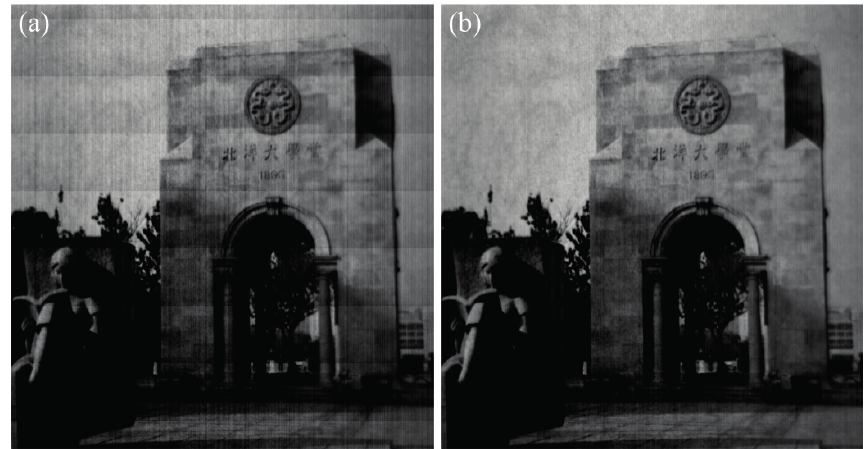
Figure 19. Comparison of visual effect of the Peiyang University Memorial. ( a ) Original image; ( b ) Corrected